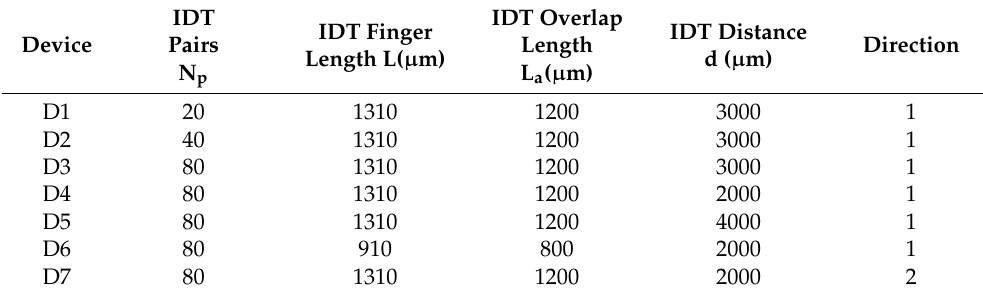
Table 1. Summary of the realized delay lines